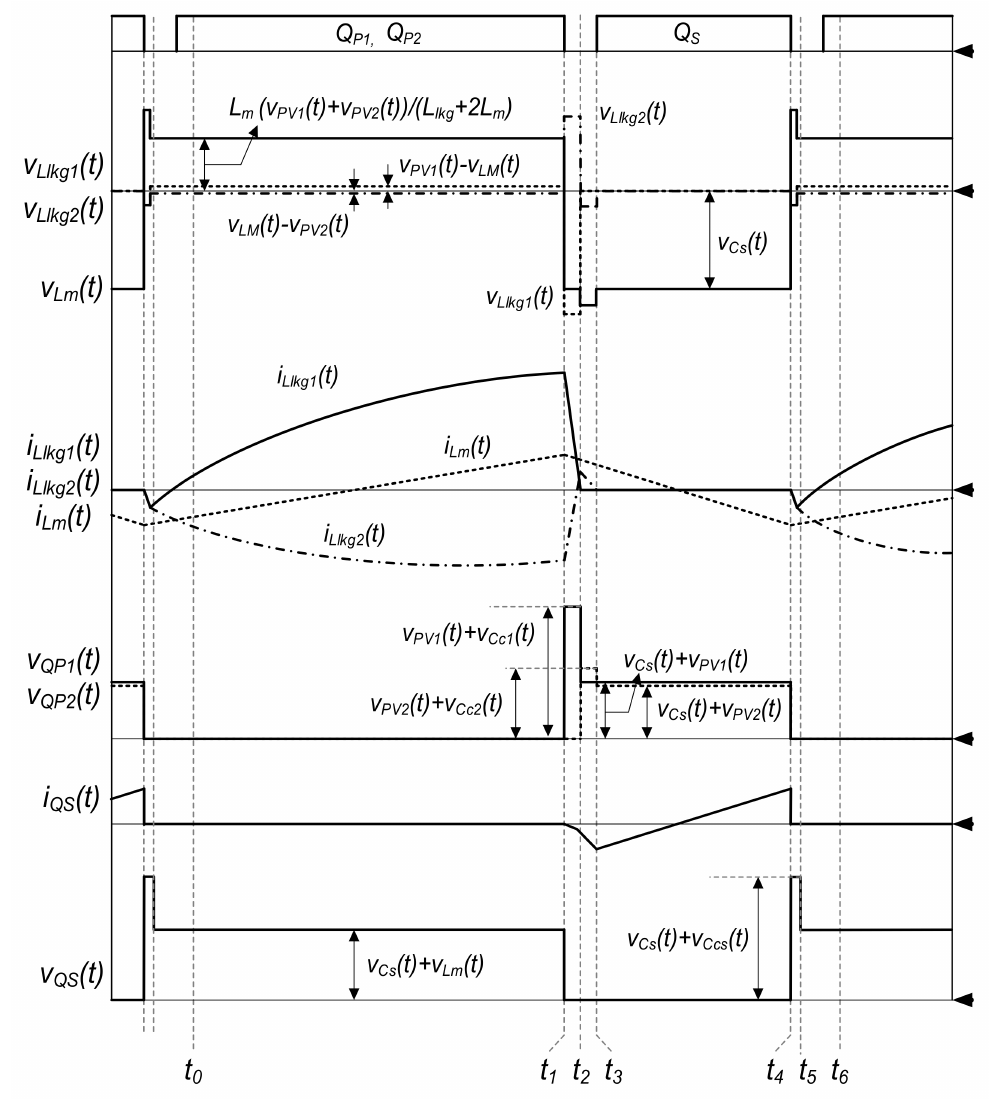
Figure 3. Operational key waveforms of the